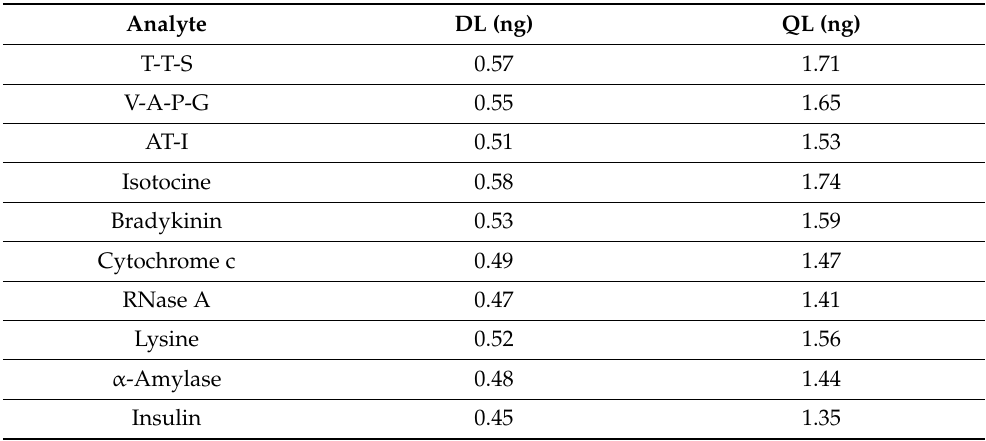
Table 5. DL and QL values determined for peptides and proteins using HPLC-UV detection at 214 nm.